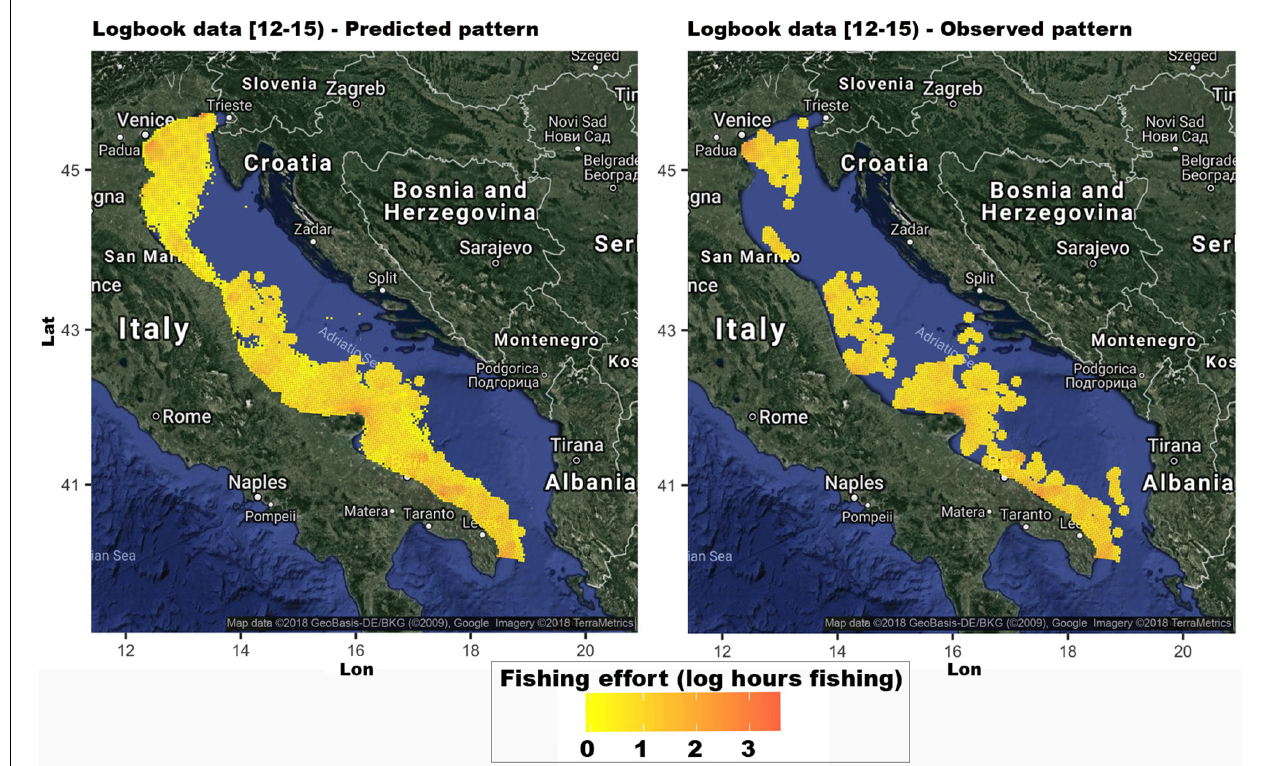
FIGURE 10 | Comparison of the fishing footprint (as the total fishing effort in the year 2017) predicted (left) by the CMPN 10 − 8 , for the 39 vessels in the logbook dataset and the corresponding pattern (right) computed from the logbook data. The figures were created using the R package ggmap (Kahle and Wickham, 2013) importing images from Google